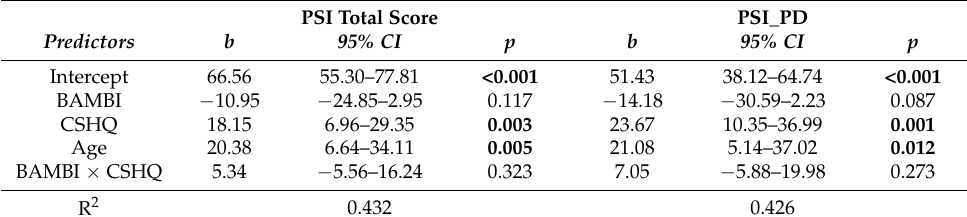
Table 4. Linear regression models with BPI scores as dependent variables.